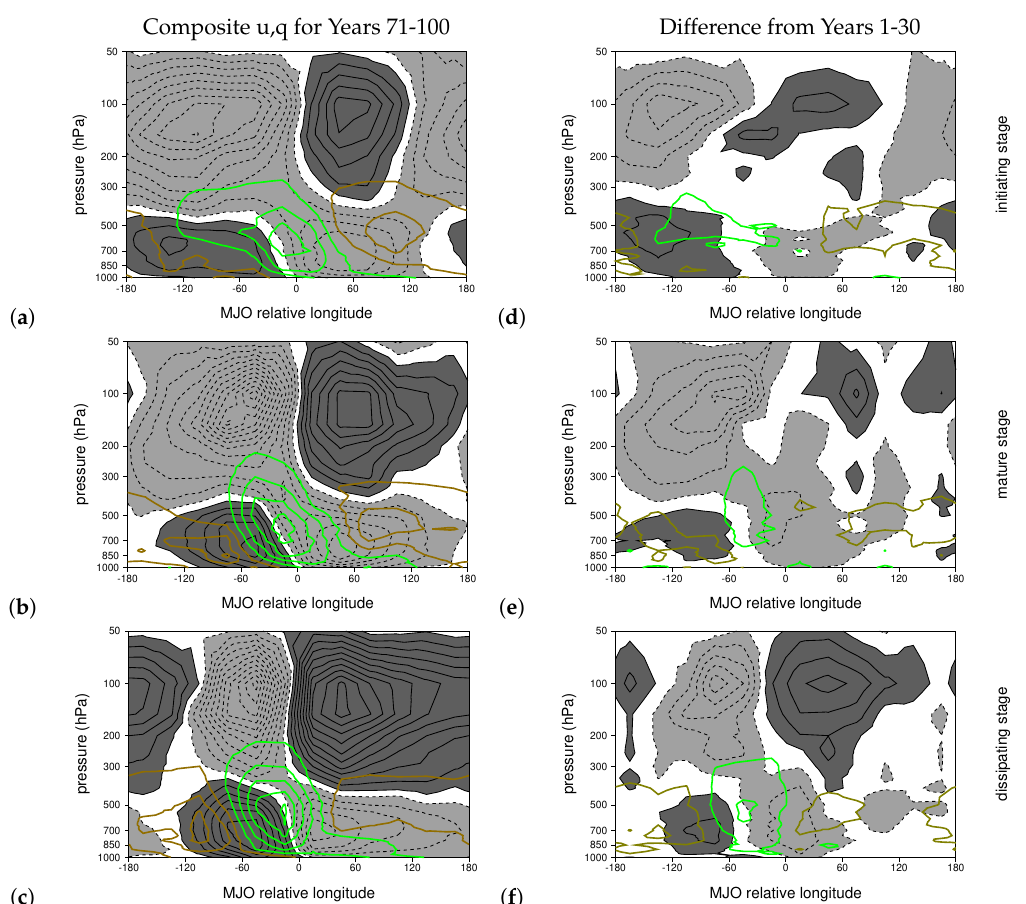
Figure 10. The change in MJO zonal wind and moisture perturbations during the course of the simulation. ( a – c ) Year 71–100 composite MJO zonal wind and moisture perturbations for the initiating, mature, and dissipating stages respectively. ( d – f ) The difference between Year 71–100 moisture and temperature perturbations and those for Years 1–30 for the initiating, mature, and dissipating stages respectively. Zonal wind and moisture perturbations are contoured as in Figure